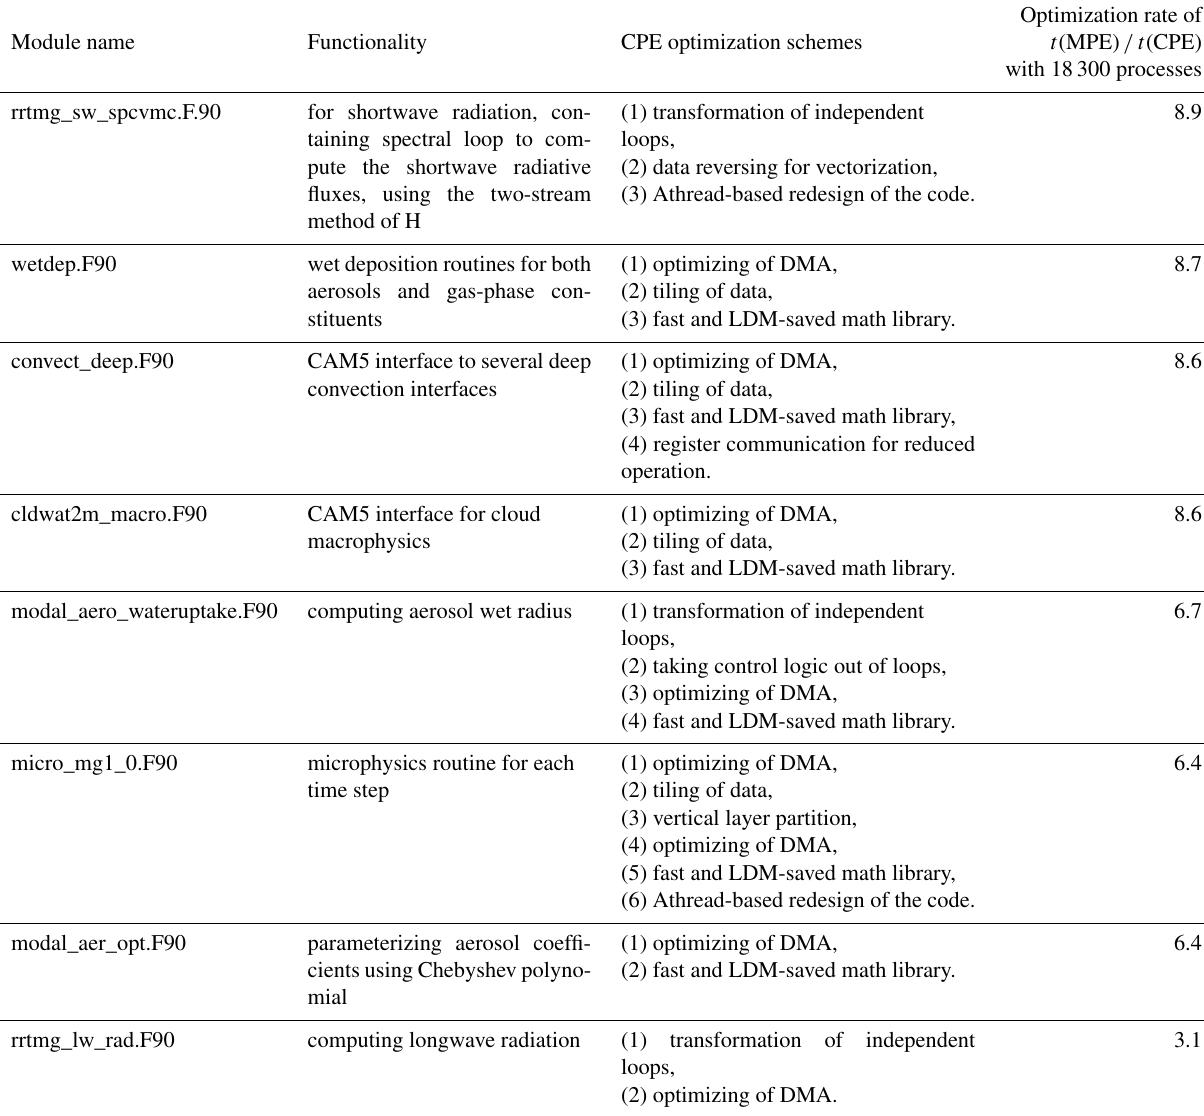
Optimization rate